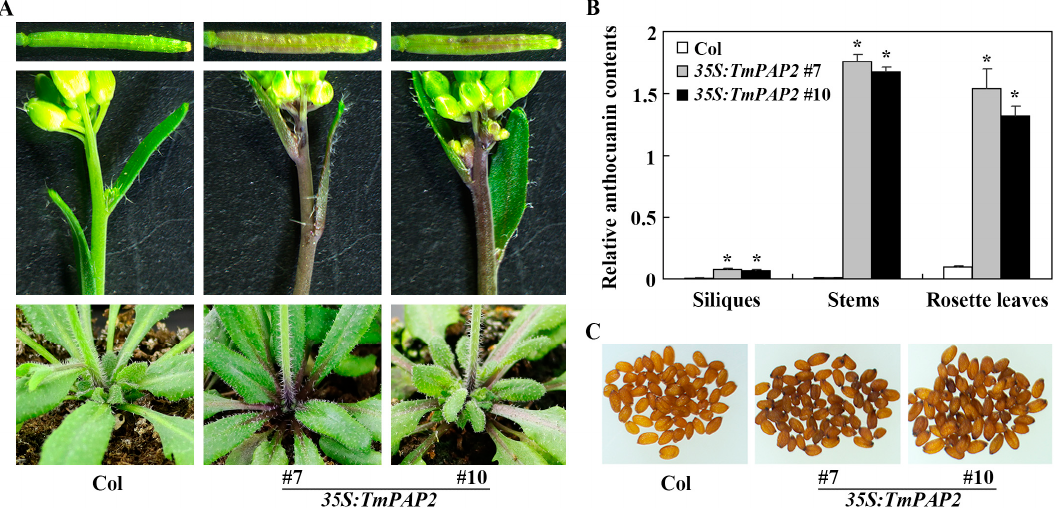
Figure 4. Anthocyanin accumulation in the Col wild-type and the 35S:TmPAP2 transgenic Arabidopsis plants. ( A ) Anthocyanin accumulation in the siliques (upper panels), stems (middle panels), and rosette leaves (lower panels) of 5-week-old soil-grown plants of the Col wild-type and the 35:TmPAP2 transgenic plants. ( B ) Relative anthocyanin contents in the Col wild-type and the 35S:TmPAP2 transgenic plants. Data represent the mean ± SD of three biological repeats. * Significant difference from the Col wild-type plants ( p < 0.001). ( C ) Seed colors of the Col wild-type and the 35S:TmPAP2 transgenic plants. Pictures were taken under an OPTIKA microscope connected to a digital camera.